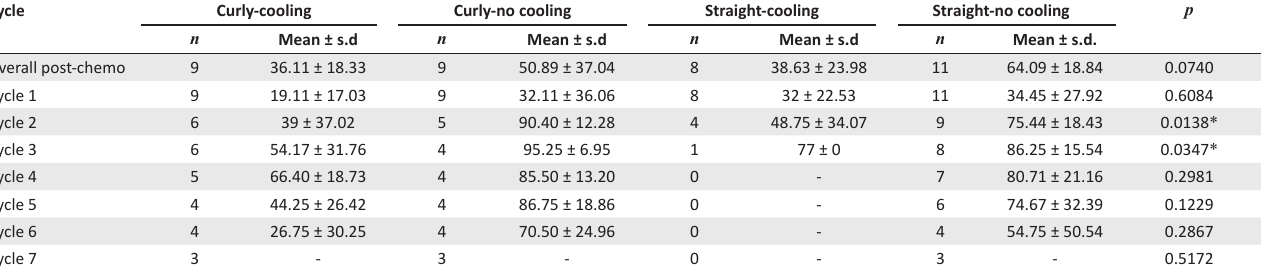
TABLE 4: Comparative chemotherapy-induced alopecia through each cycle of treatment across the following groups: curly hair-cooling, curly hair-no cooling, straight hair- cooling, straight hair-no cooling.